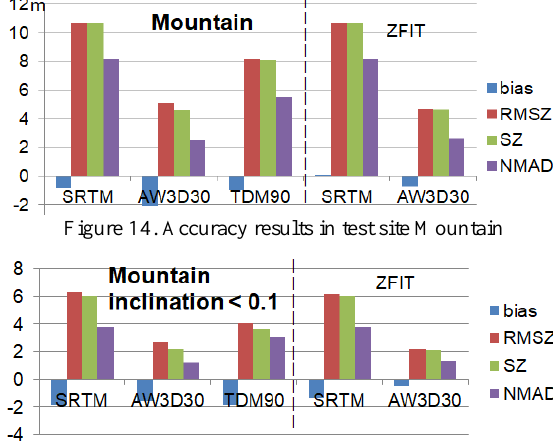
Figure 15. Accuracy results in test site Mountain for inclination < 0.1